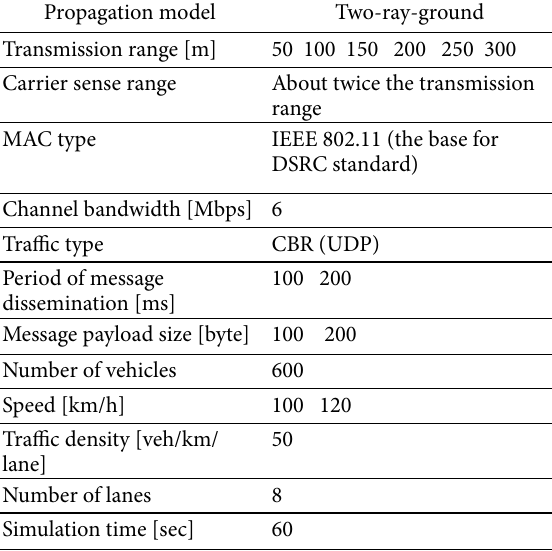
Table 2. Simulation setting parameters